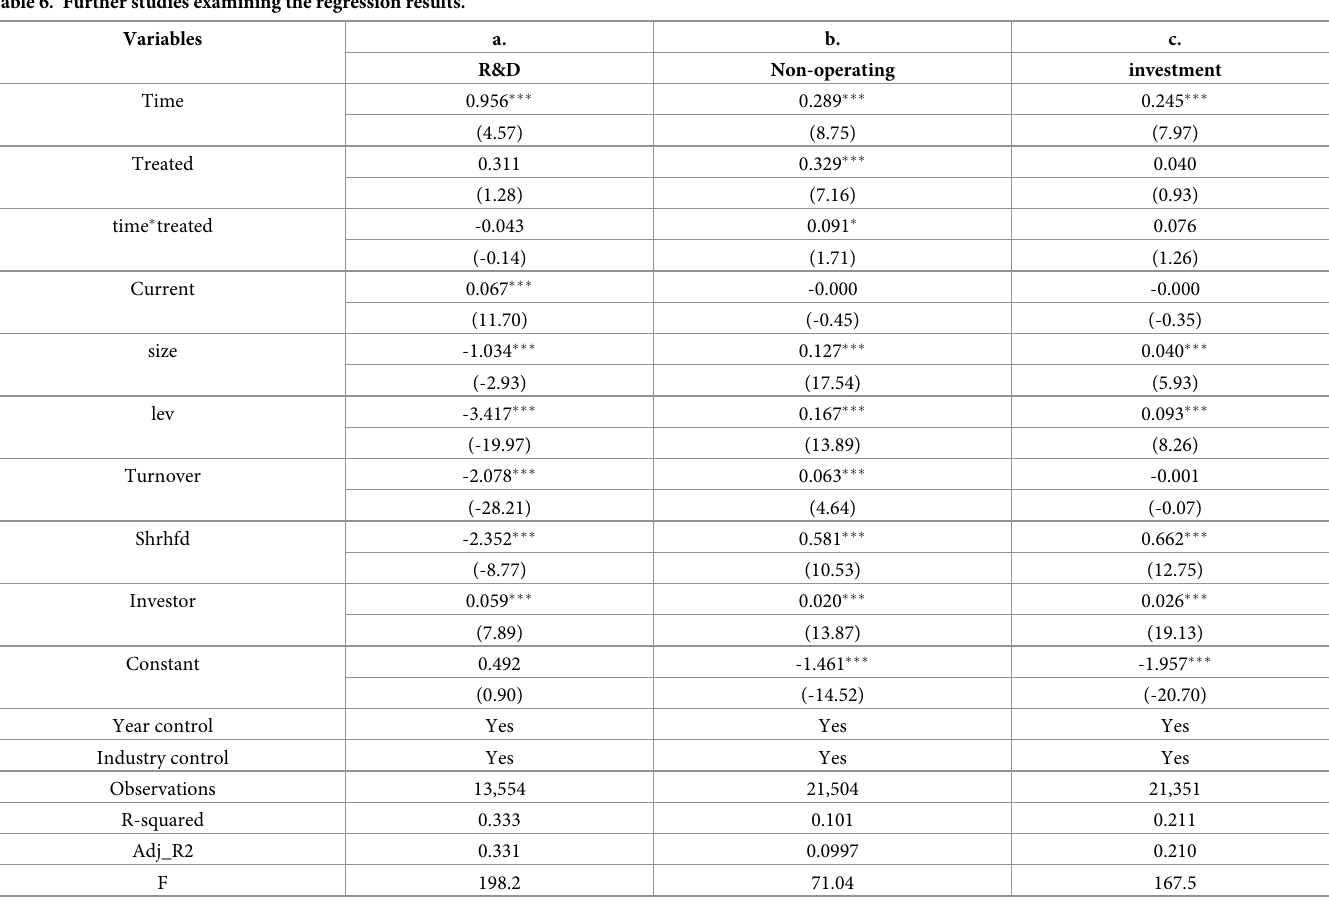
Table 6. Further studies examining the regression results.